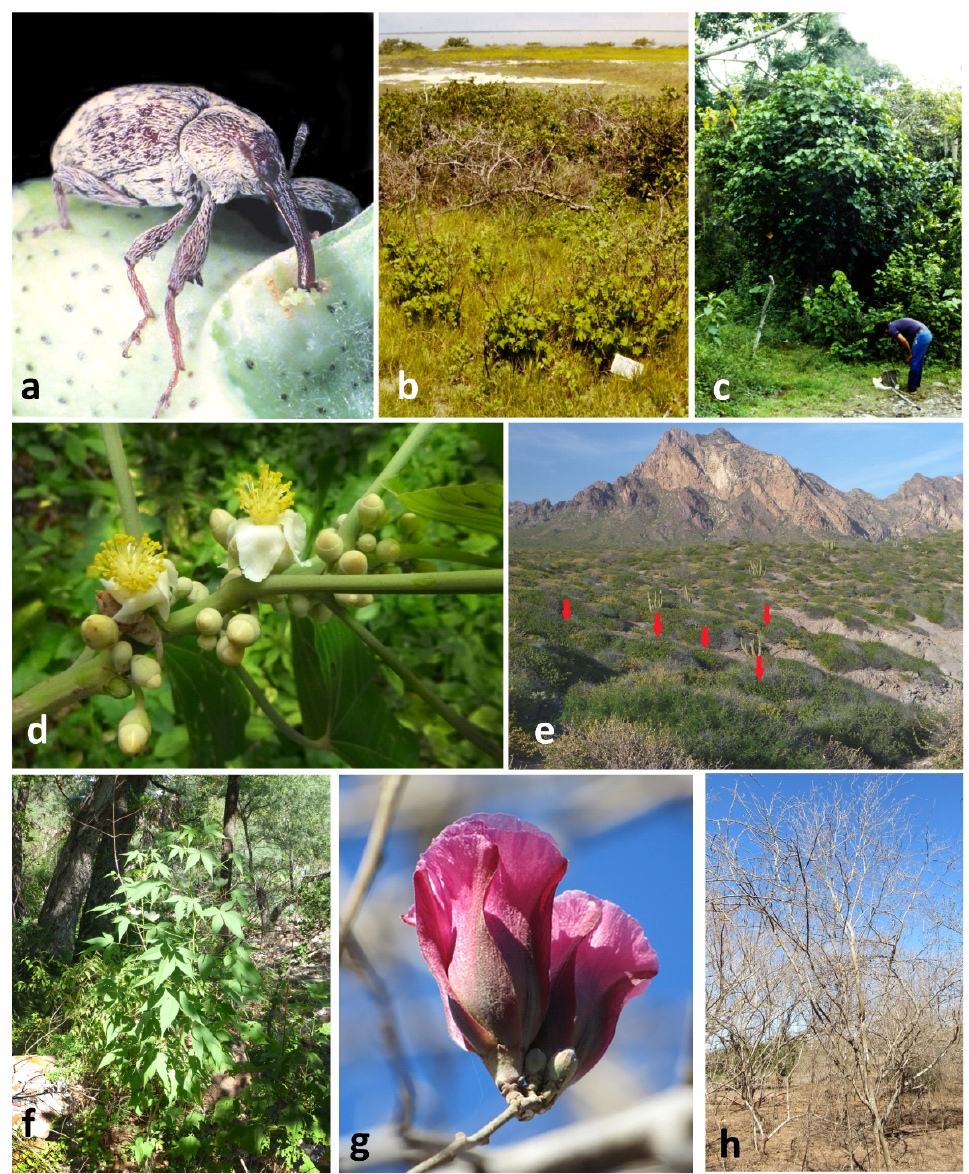
Figure 1. ( a ) The boll weevil, Anthonomus grandis Boheman (Photo: Winfield Sterling); ( b ) Wild Gossypim hirsutum (foreground) in strand vegetation on shores of the Laguna Madre of Tamaulipas, Mexico (Photo: R. W. Jones); ( c ) Medium sized tree (center) of Hampea nutricia Fryxell near Poza Rica, Veracruz, Mexico (Photo: R. W. Jones); ( d ) Branch of H. nutricia showing multiple male flower buds per leaf axil; all potential boll weevil oviposition sites (Photo: R. W. Jones); ( e ) Habitat of Gossypium turneri Fryxell near shoreline of Pacific Ocean in Sonora, arrows indicating cotton plants (Photo: R. W. Jones); ( f ) Gossypium thurberi Todara in isolated canyon northeast of Sahuaripa, Sonora, Mexico (Photo: R. W. Jones); ( g ) Flower buds and flower of Gossyium aridum (Rose & Standley ex Rose) Skovsted (Photo: CC © Francisco Miguel Farriols Estrada, By-NC) [26]; ( h ) Deciduous small tree of G. aridum during dry season in Sinaloa, Mexico (Photo: CC © Francisco Miguel Farriols Estrada, By-NC) [27].